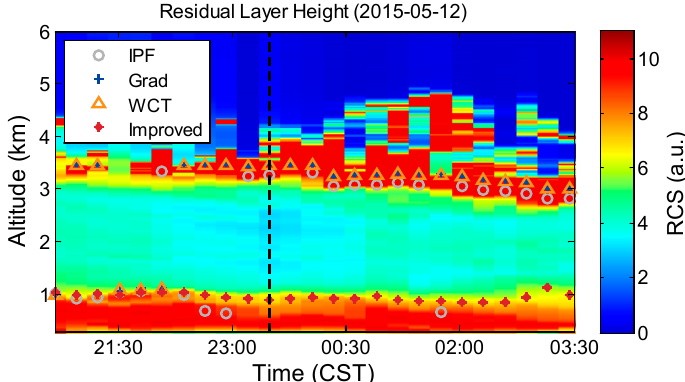
Figure 4. RCS measured by elastic Lidar from 20:00, 12 May 2015 to 03:30, 13 May 2015 CST; RLHs were determined with IPF, Grad, WCT, and improved method with RCS.